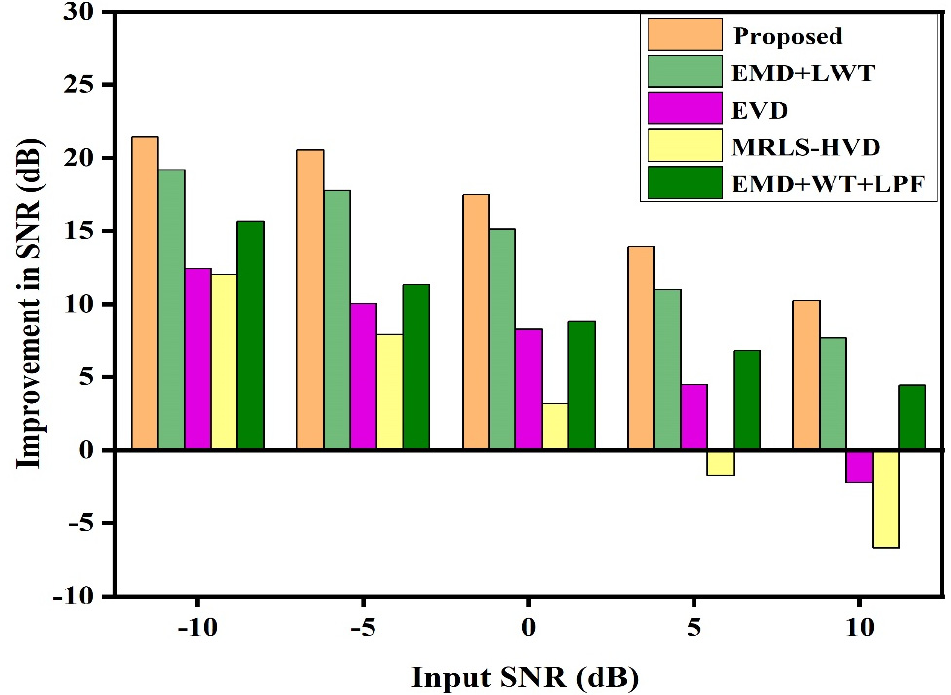
Figure 11. Comparison between the proposed method and various other methods in terms of average improvements generated in the output SNR in presence of 50 Hz PLI and baseline wander.